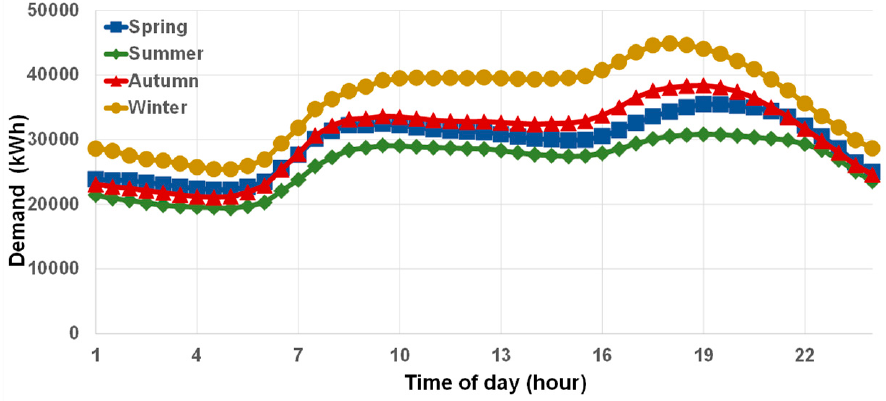
Figure 3. UK national electricity demand profile (adapted from [16]).